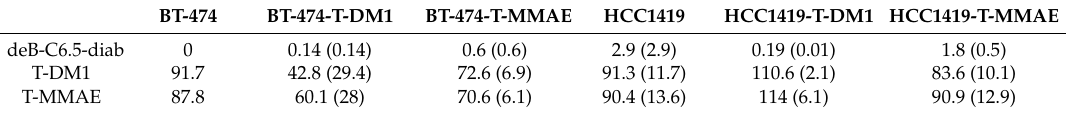
Figure 5. ( A ) Representative images of tumorospheres from untreated (NT) HCC1419 cells or cells treated with 10 nM deB-C6.5-diab, T-DM1, or T-MMAE. ( B ) Representative images of tumorospheres from HCC1419 cells surviving T-DM1 or T-MMAE treatment incubated under tumorosphere-forming conditions in the presence of 10 nM deB-C6.5-diab, T-DM1, or T-MMAE. Table 3. Effect of deB-C6.5-diab, T-DM1, and T-MMAE on tumorosphere forming